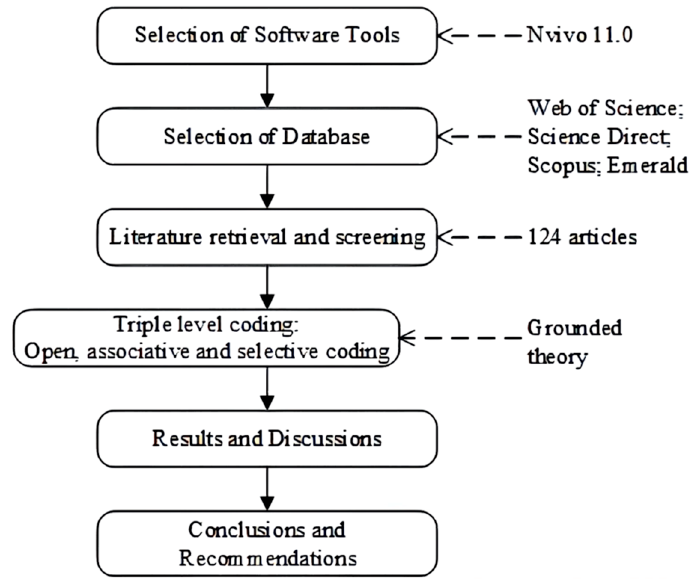
Figure 3. Research method flowchart.